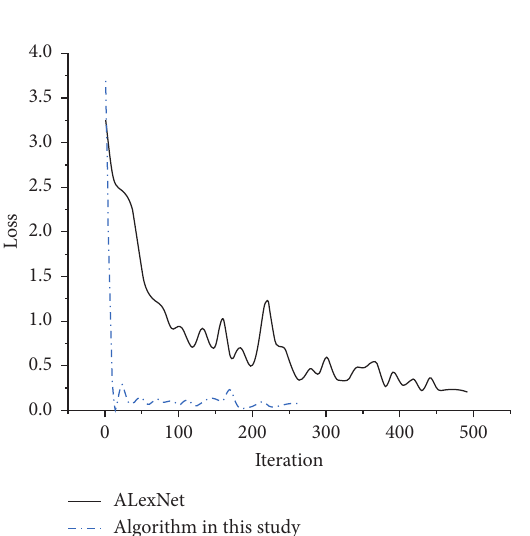
Figure 10: Loss during